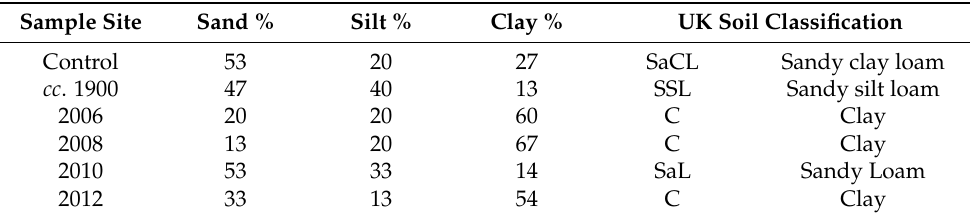
Table 1. Soil percentiles and texture classification of each sample site.